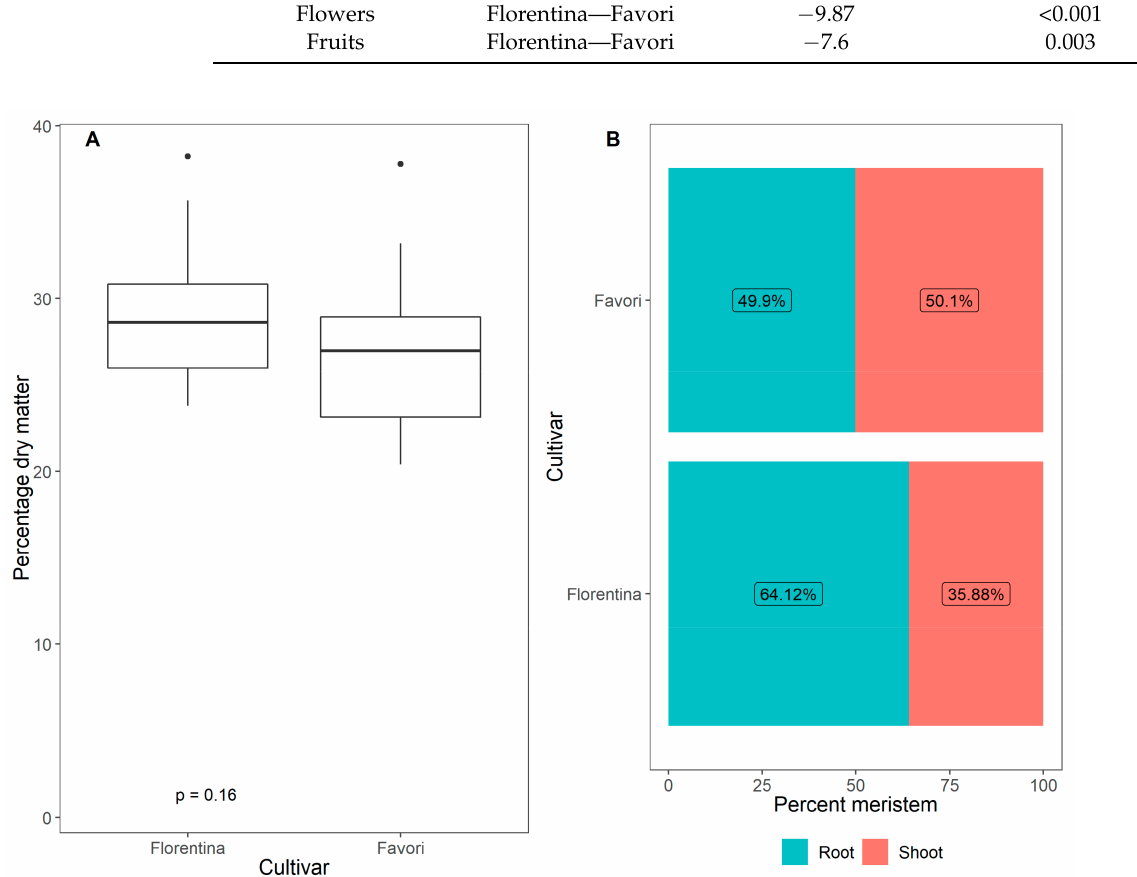
Figure A2. Accumulated biomass (%) ( A ) and percentage distribution of dry matter in the shoots and roots ( B ) of the strawberry cvs. ‘Florentina’ and ‘Favori’ grown for 14 weeks under ambient LD condition in a greenhouse at 20 ◦ C. The p -value for the ANOVA analysis is stated at the bottom of the